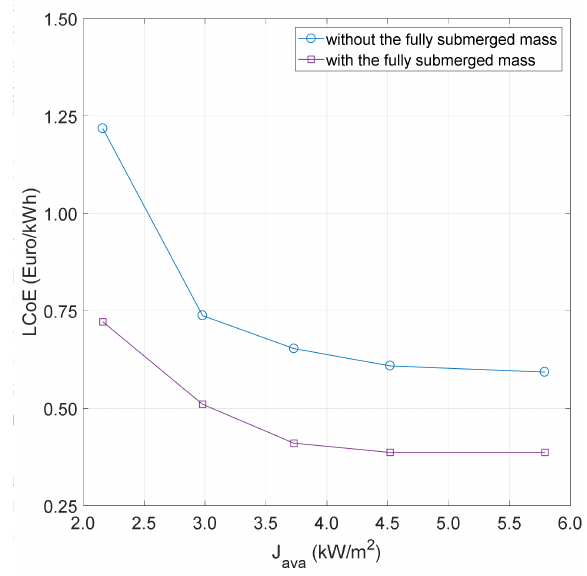
Figure 9. LCoE distribution versus J ava